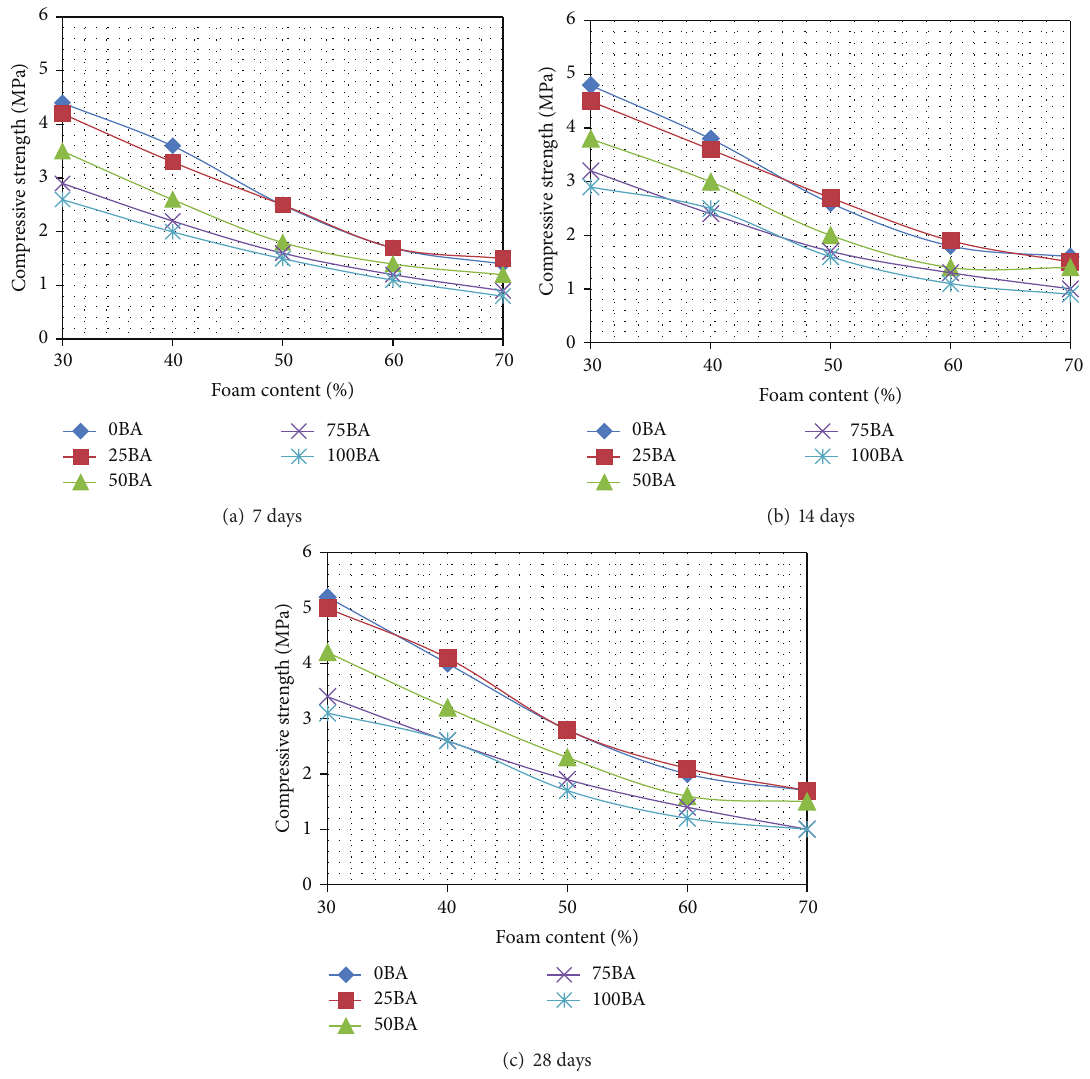
Figure 4: The compressive strength of cellular